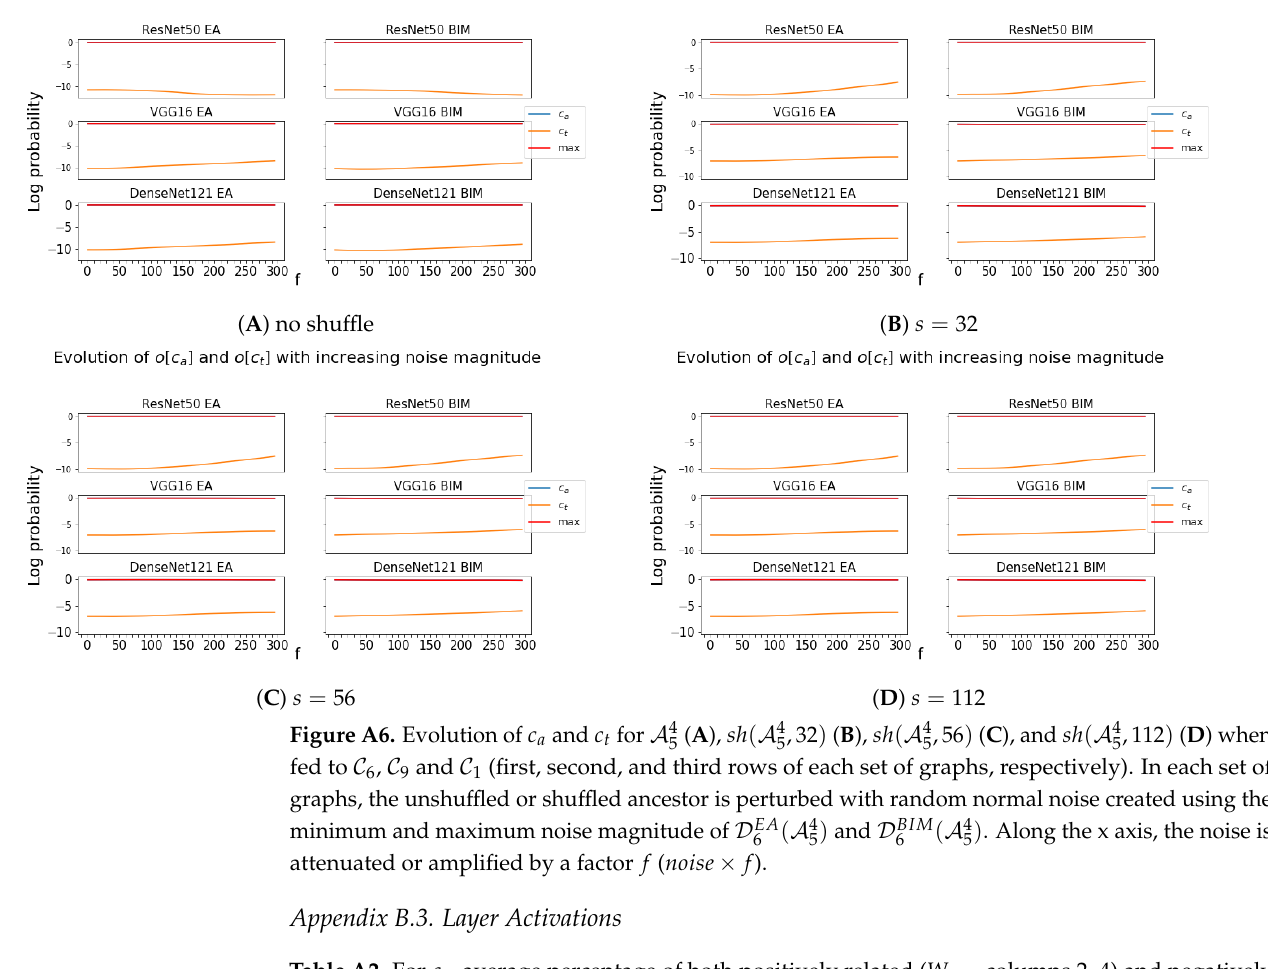
Table A2. For c a , average percentage of both positively related ( W pos , columns 2–4) and negatively related ( W neg , columns 5–7) units in which the activation increased ( ∆ pos ), stagnated ( ∆ 0 ), or decreased ( ∆ neg ). In each row, the respective CNN is only fed with C 1 ’s adversarial images D atk contains the results for EA and